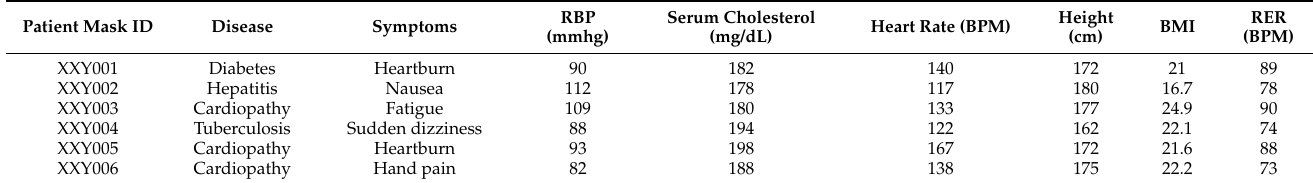
Table 2. Example data with key